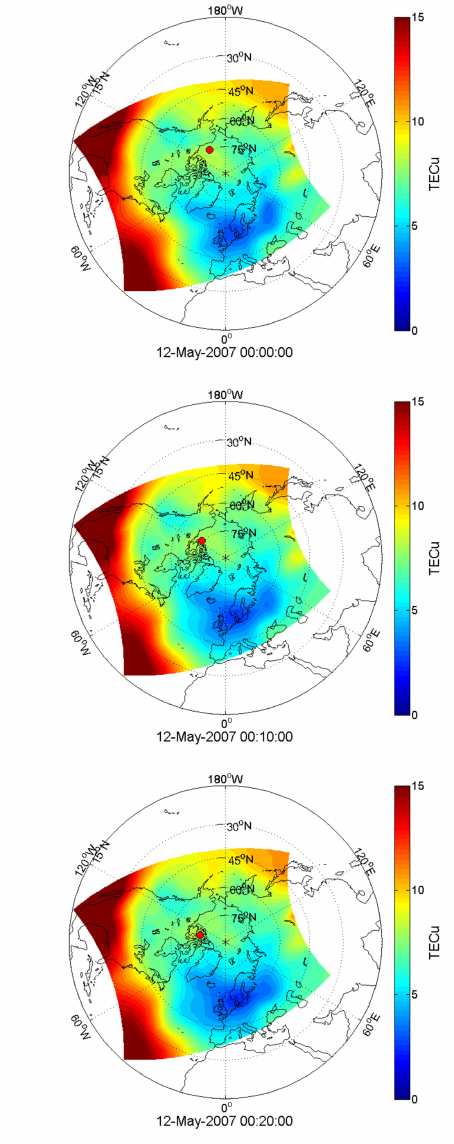
Fig. 7. A time series of MIDAS images showing a patch evolving and the patch maximum as identified by TRACK (red marker). All times are